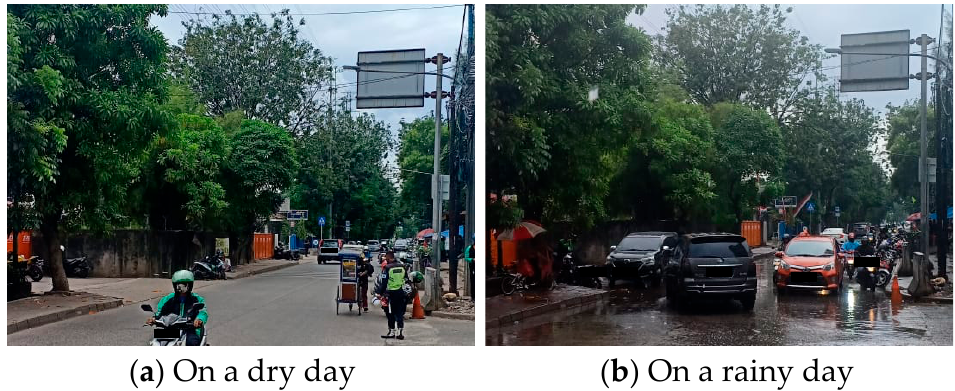
Figure 1. Pegangsaan Dua Road’s traffic condition in Jakarta, Indonesia, on dry ( a ) and rainy days ( b ). To avoid the bias, both photos were taken at the similar time. The photo ( a ) was taken on Thursday, 16 July 2020, at 2:30 p.m. while photo ( b ) was taken on Thursday, 13 August 2020, at 2:33 p.m. on exactly the same spot. No particular event was hosted nearby. The main difference between ( a ) and ( b ) is the weather condition.